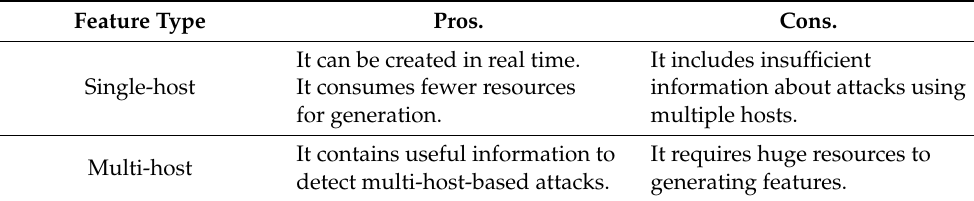
Table 1. Comparison for single-host and multi-host